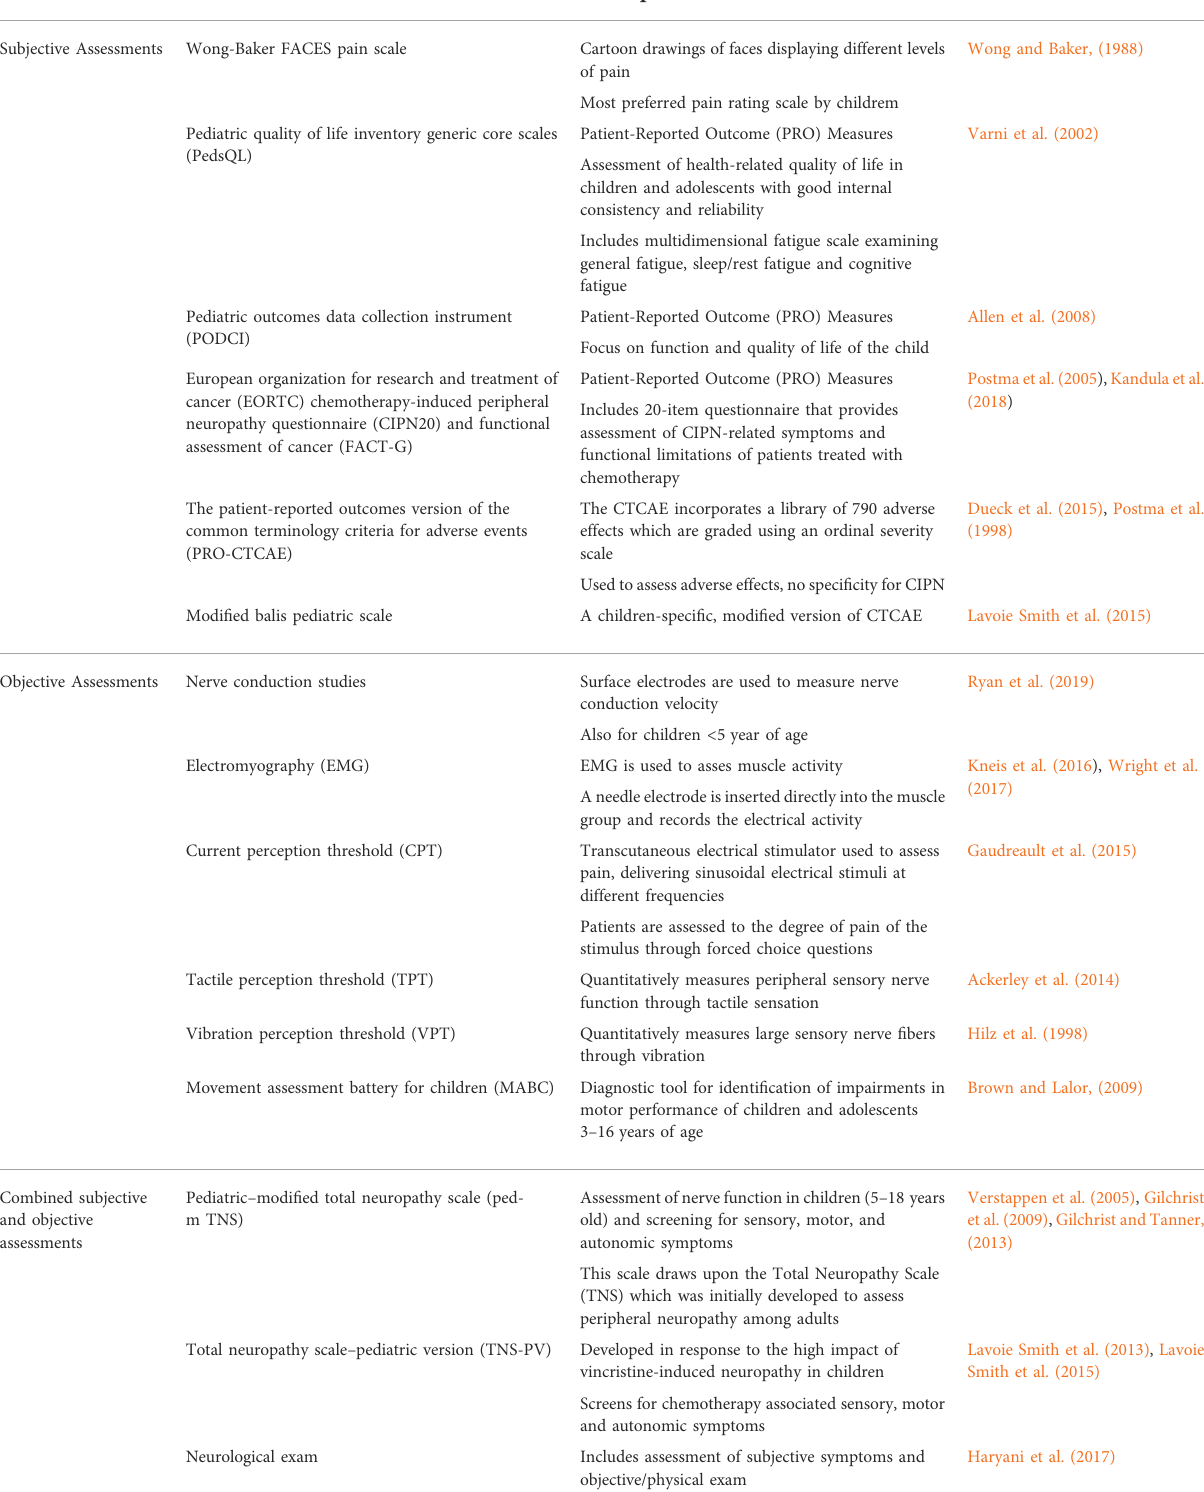
TABLE 4 Tools used for the assessment and diagnosis of pediatric